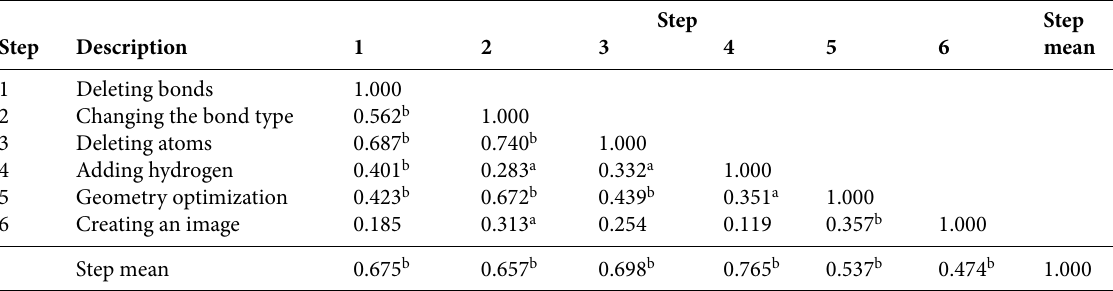
Table 11: Spearman correlations between step difficulty levels within Activity